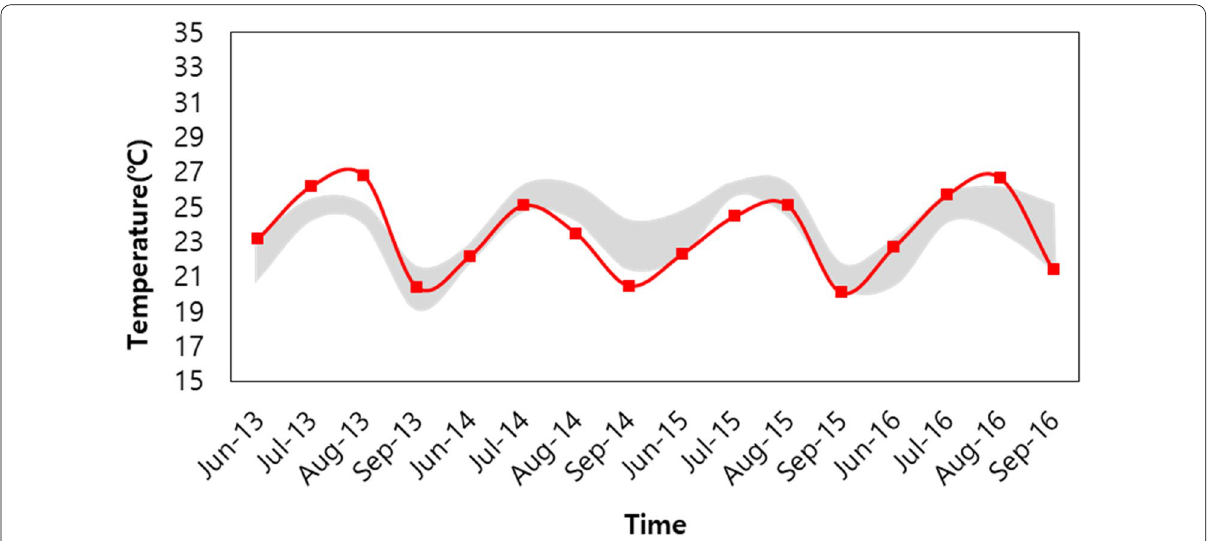
Fig. 7 Results of the temperature prediction model based on teleconnection